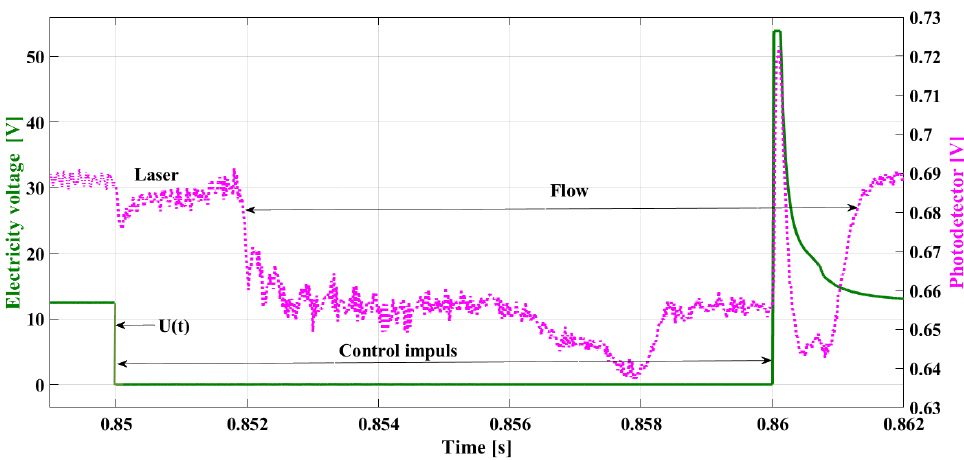
Figure 2. Delay of the fuel flow relative to the impulse controlling the fuel